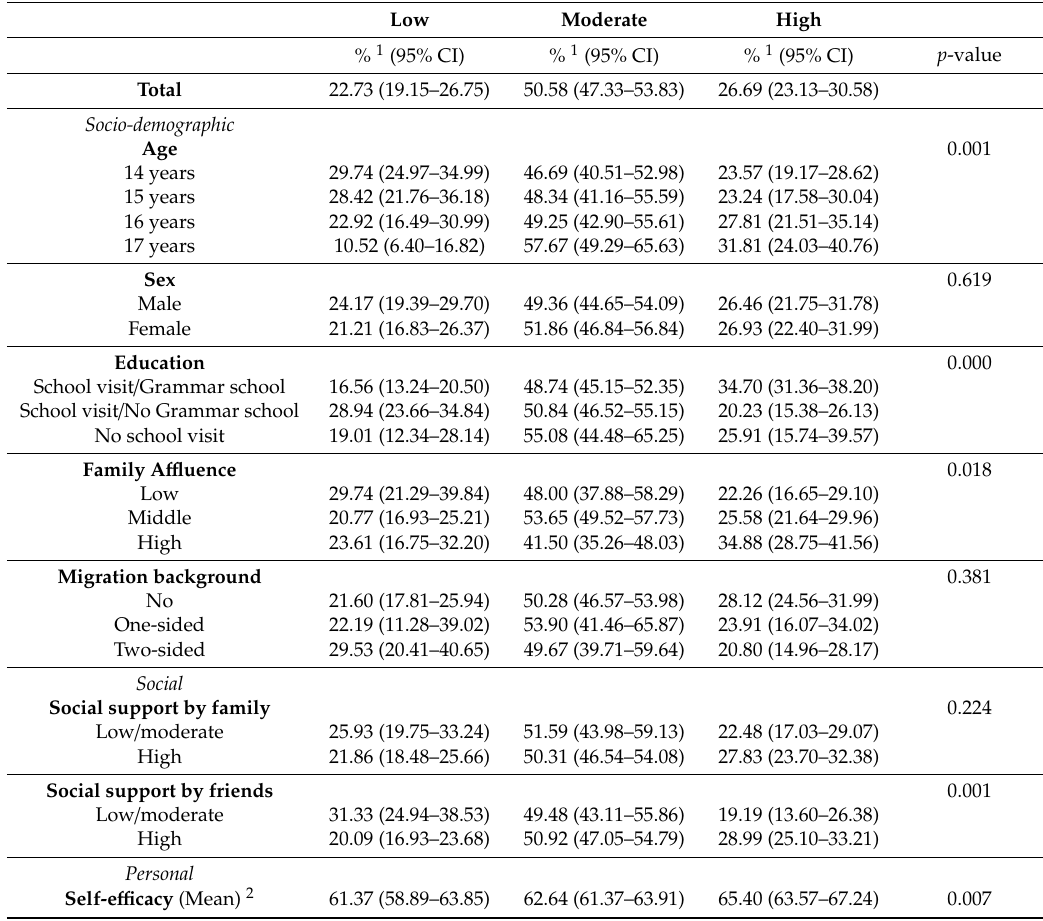
Table 6. Scale D: Weighted percentages and bivariate associations of level of health-related knowledge and considered factors among adolescents aged 14–17 ( n = 1202) based on GeKoJu 2019